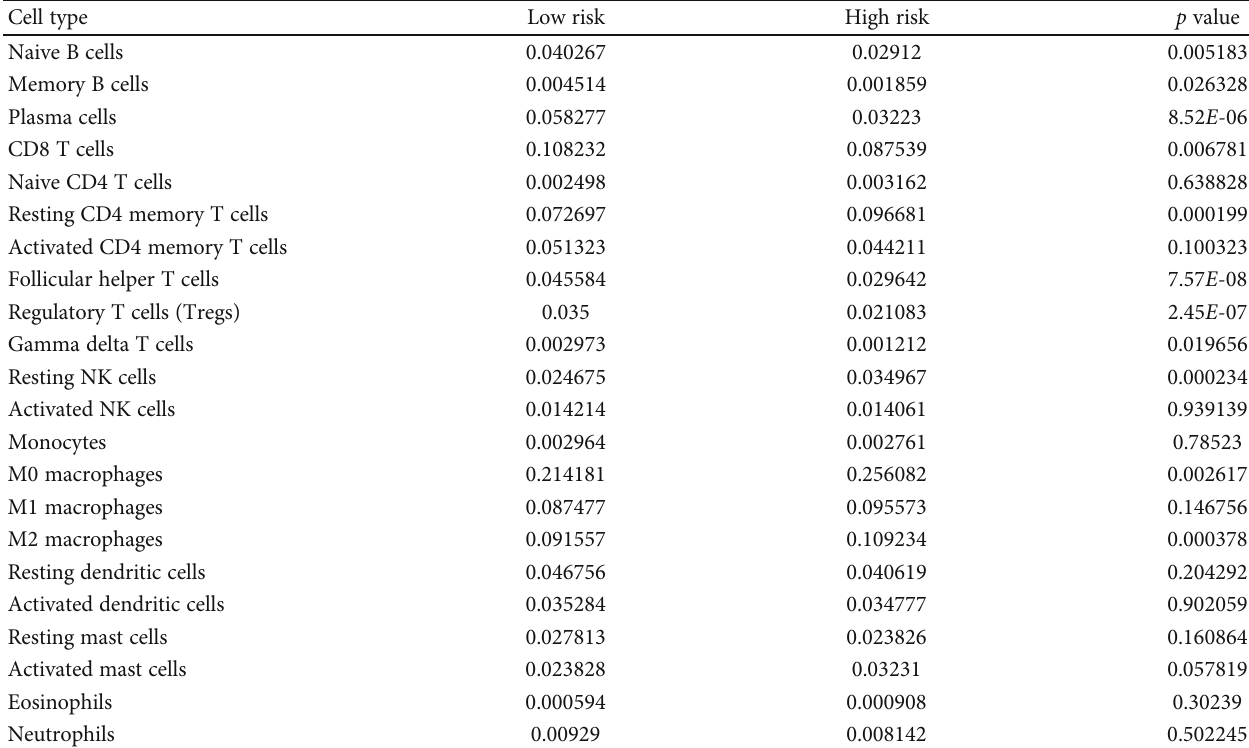
Table 4: Di ff erential immune cell type expression was observed between the high- and low-RS groups in the TCGA